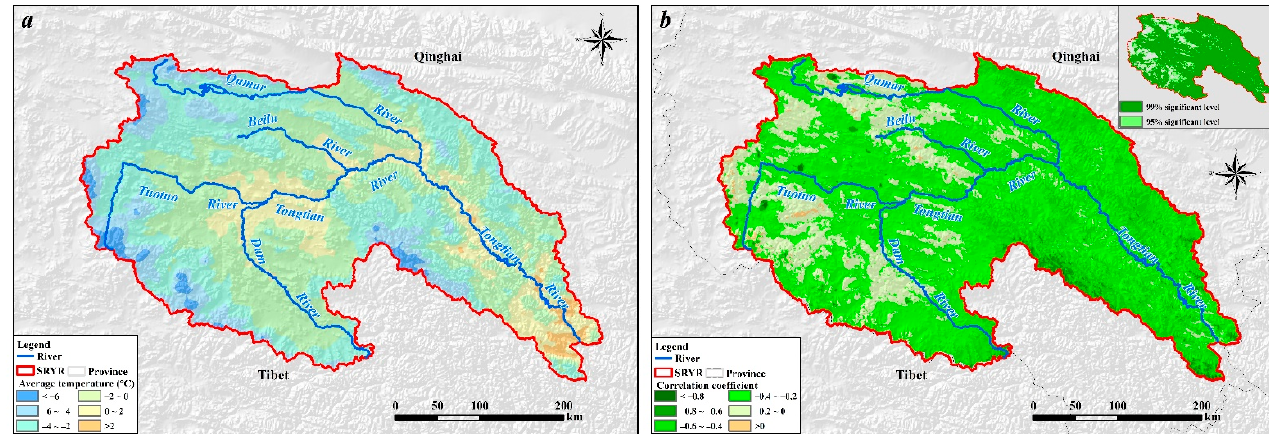
Figure 7. Average temperature of SRYR ( a ) and correlation coefficient between SCD and tempera- ture ( b